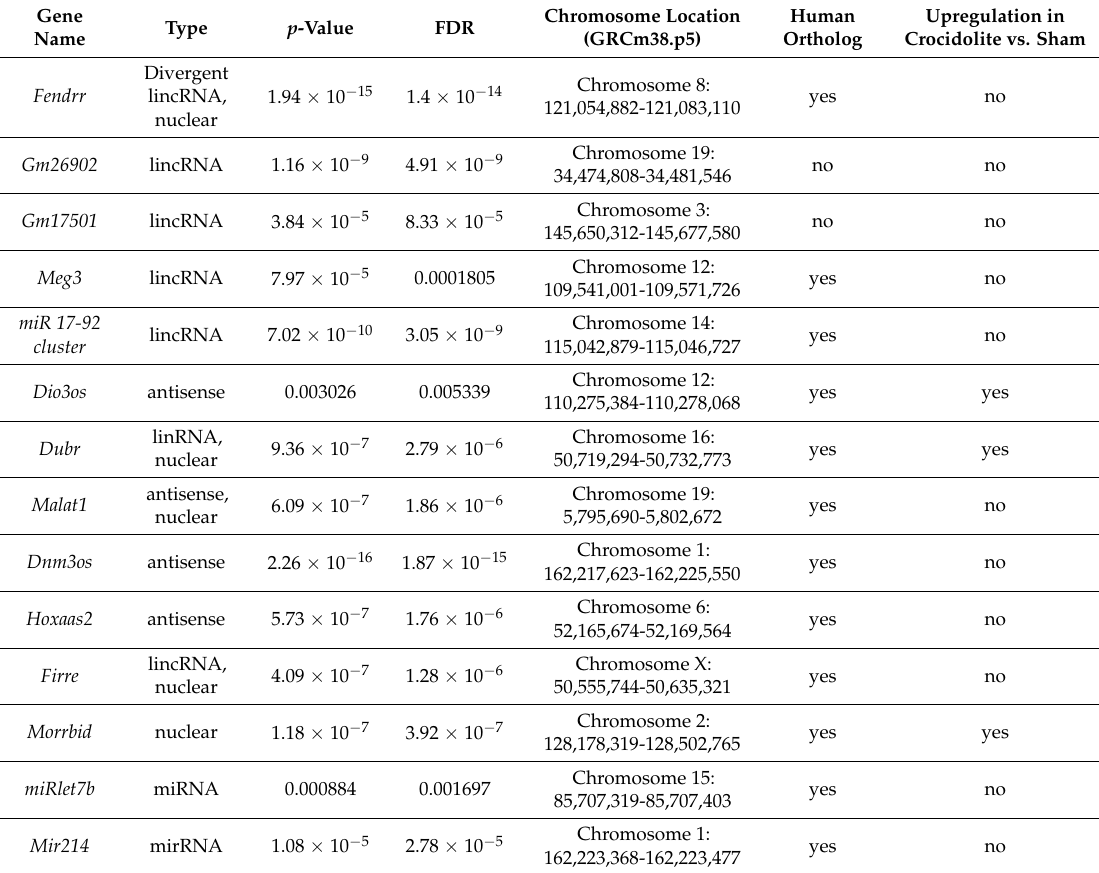
Table 1. Selected non-coding RNA more than 2-fold upregulated in murine mesothelioma compared to inflamed crocidolite-exposed